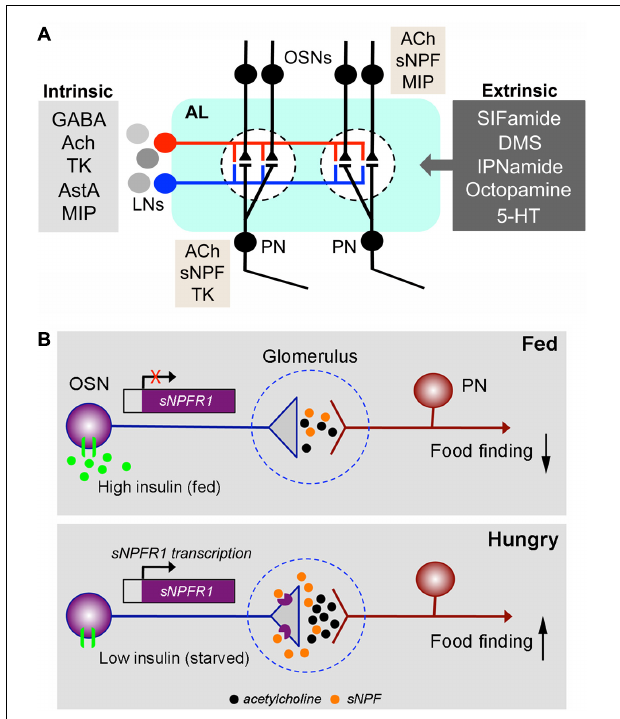
FIGURE 8 | Coexpression and neuromodulation in the olfactory system. (A) Neuromodulation in the Drosophila antennal lobe. The antennal lobe (AL) is shown highly schematically with only two glomeruli (dashed outlines). Inputs to the glomeruli are from OSNs in the antenna and labial palps. The OSNs synapse on PN that relay signals to higher brain centers (MBs and lateral horn). The OSNs and PNs are modulated by local neurons (LNs), which form intrinsic modulatory circuits and by extrinsic neurons that utilize several neurotransmitters/neuromodulators. The LNs are either